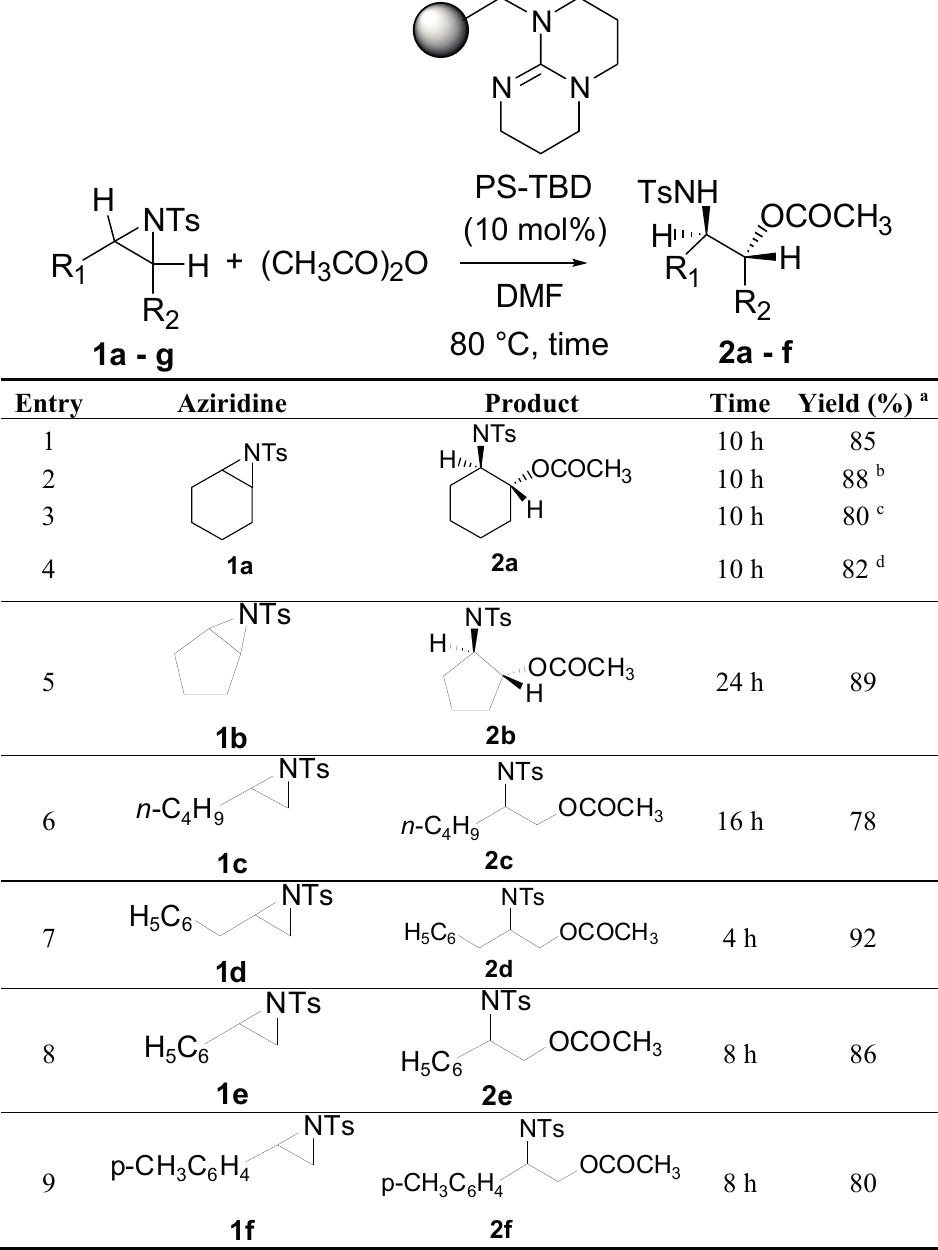
Table 3. PS-TBD catalyzed ring-opening of various aziridines with acetic